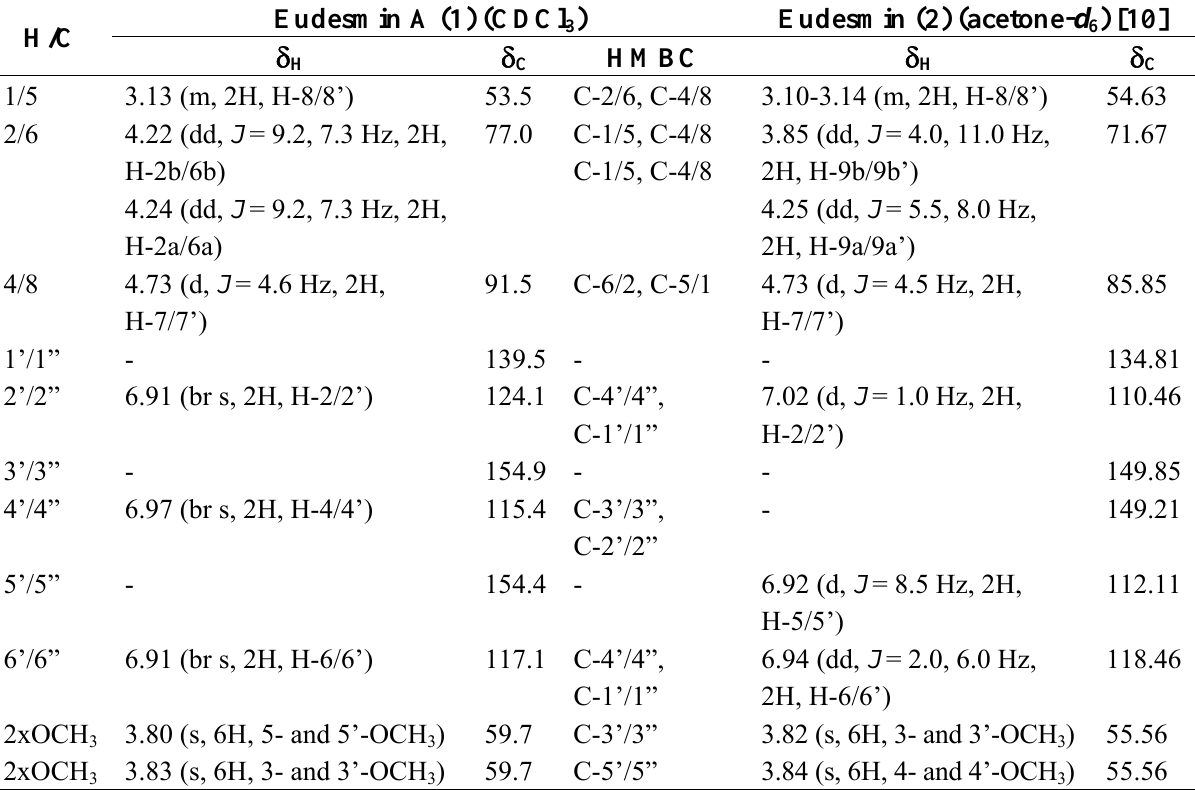
Table 1. 1 H- and 13 C-NMR data of eudesmin A ( 1 ) and eudesmin ( 2